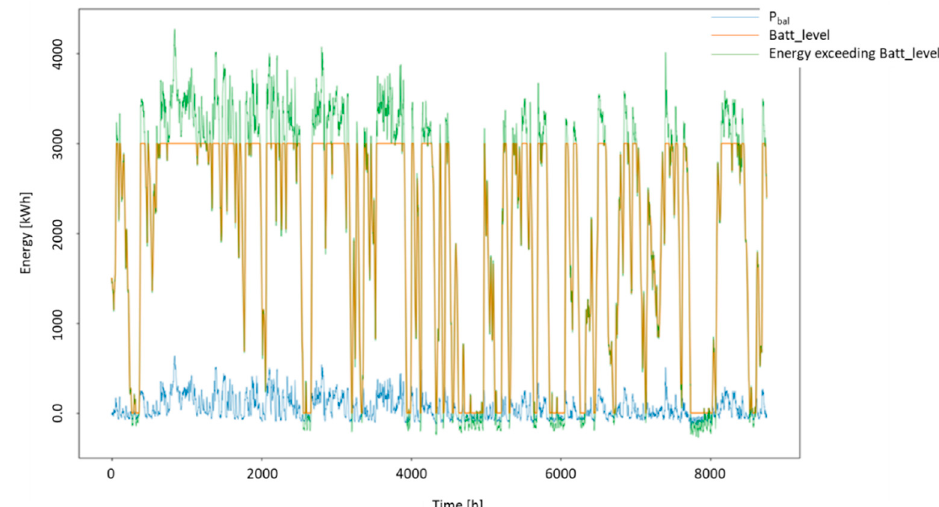
Figure 8. 2 Weptos configuration. Power balance during 8760 hours from 1 September 2016 to 31 August 2017. Pbal = Pprod − Pcons (blue), Batt_level: battery stored energy (orange), Energy Exceeding Batt_level (green): the energy that cannot be stored in the batteries, either because batteries are already full or because there is not enough energy to be stored, as it is all used for the demand. Table 5. Summary of results for 4 Weptos configuration.